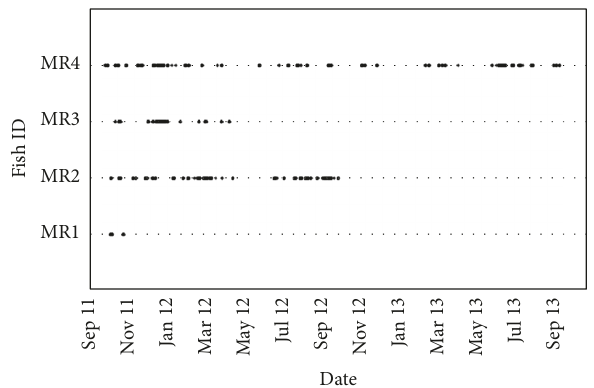
Figure 5: Daily detection of M. ramsayi at PVR from 11 September 2011 to 13 September